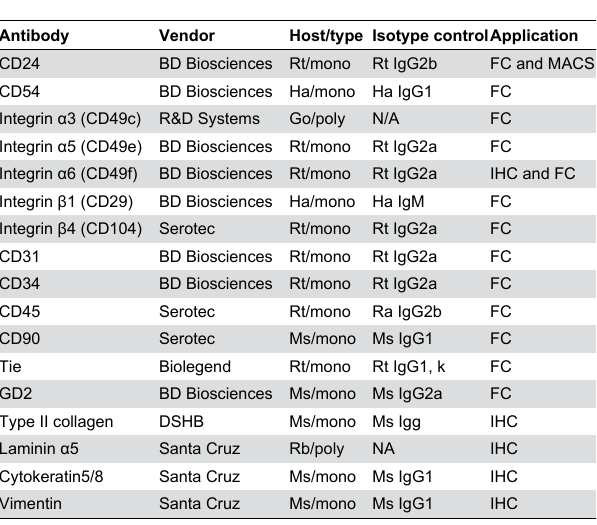
Table 1. Cell markers for NP phenotype analysis.